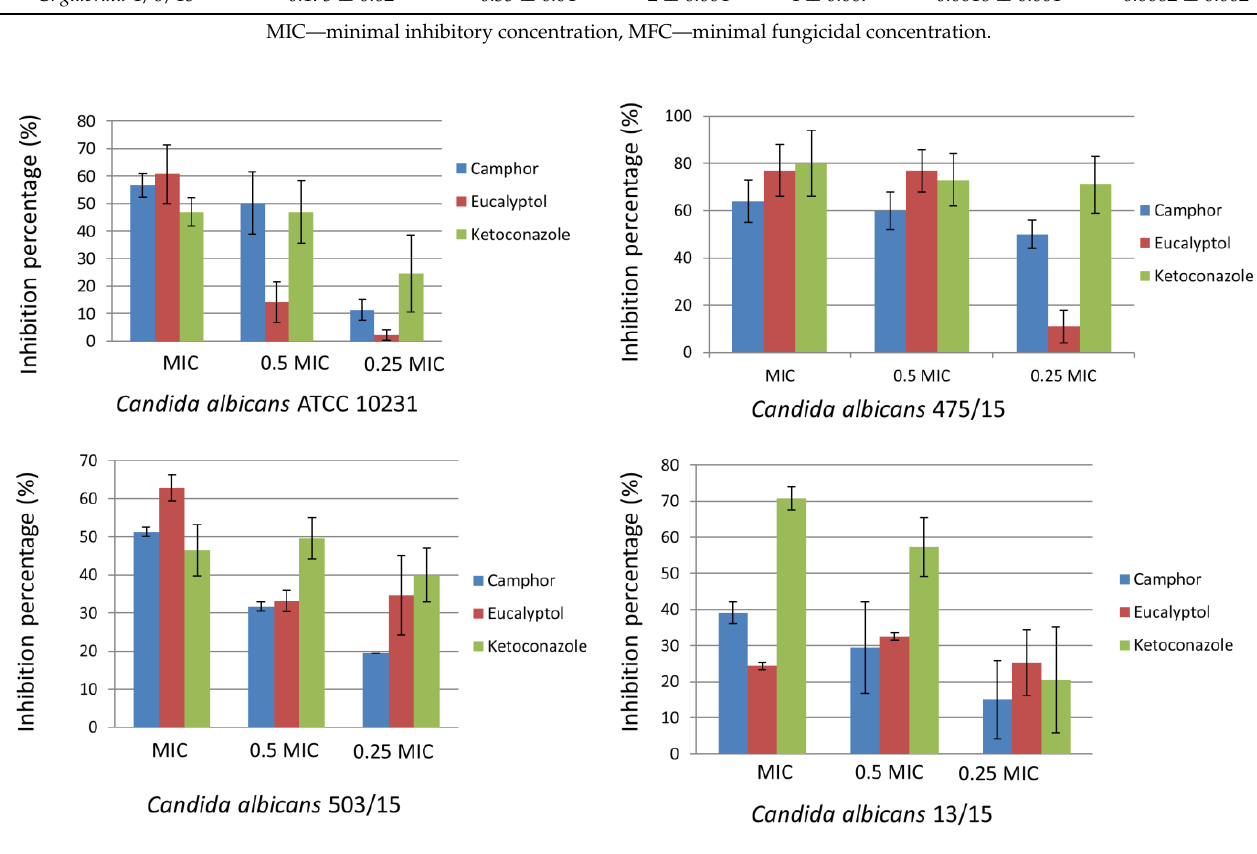
Figure 1. Inhibition of Candida albicans biofilm formation after treatment with camphor, eucalyptol and ketoconazole, expressed as inhibition percentage (100% means no biofilm was established), values represent means ± SD of three rep- licates.